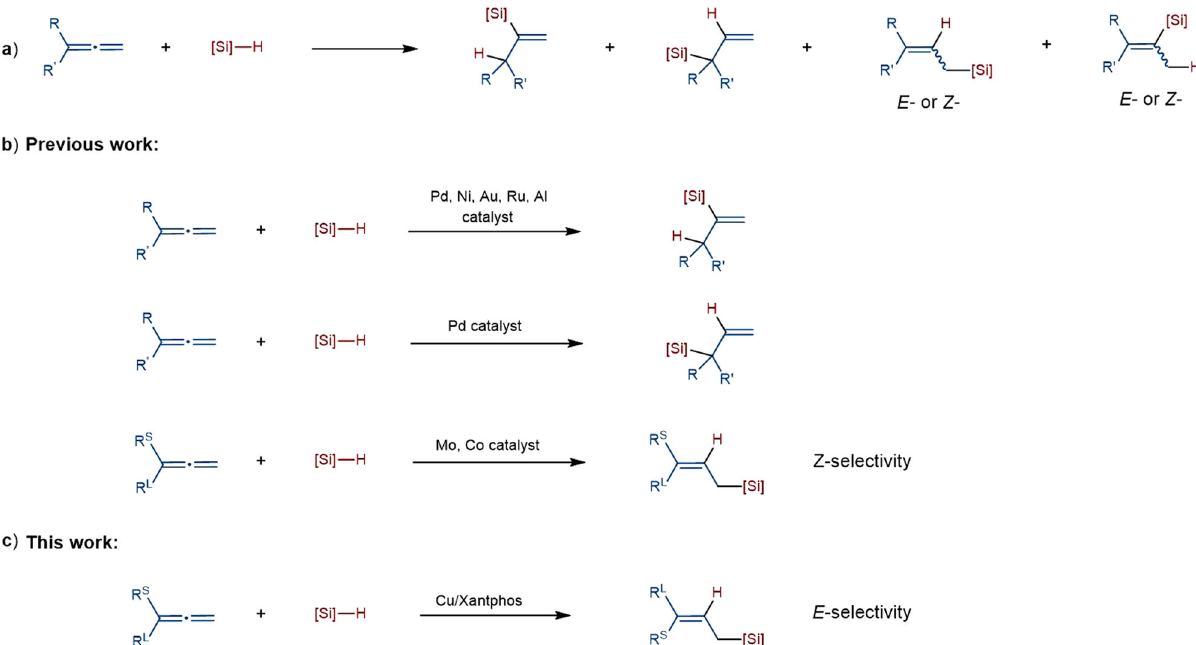
Fig. 1 Hydrosilylation of terminal allenes. a Challenges in the control of regio- and stereo-selectivity. b Previous work on the transition-metal-catalyzed hydrosilylation of terminal allenes mainly afforded vinyl silanes, branched allylsilanes and ( Z )-allylsilanes as the products. c This work: we report a copper- catalyzed selective hydrosilylation of terminal allenes to access exclusively ( E